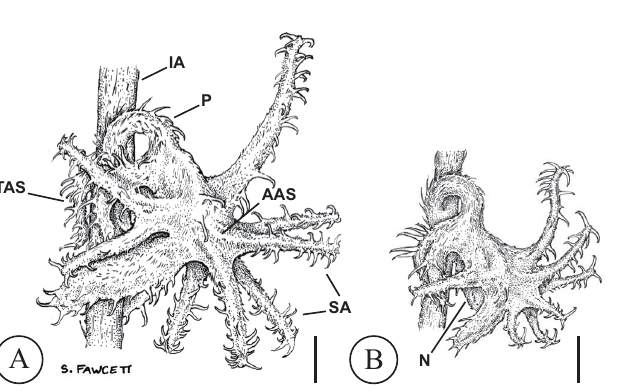
Figure 2. Fruits of Harpagonella in lateral view, from A) southern Arizona ( Tedford 1043 , ARIZ403065) and B) southern California ( Bramlet 2301 , ARIZ345225). Although morphologically similar, note overall difference in size. Scale bars are each approximately 1 mm. Labels: (AAS) sepals away from inflorescence axis in flower; (IA) inflorescence axis; (N) nutlet; (P) pedicel; (SA) sepal appendages; (TAS) sepals toward inflorescence axis in